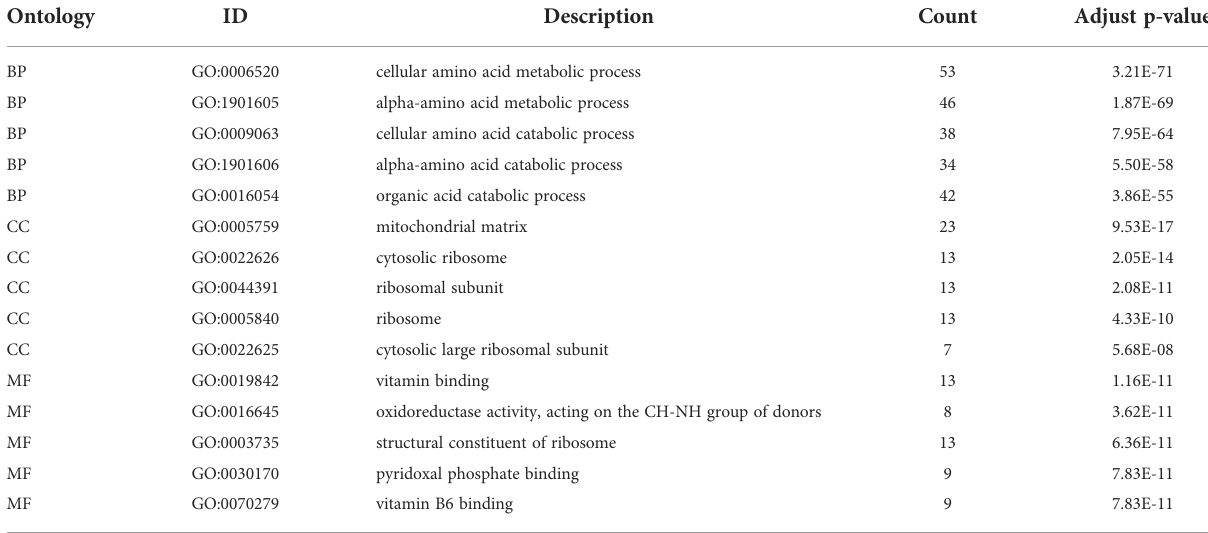
TABLE 1 GO enrichment results of differentially expressed